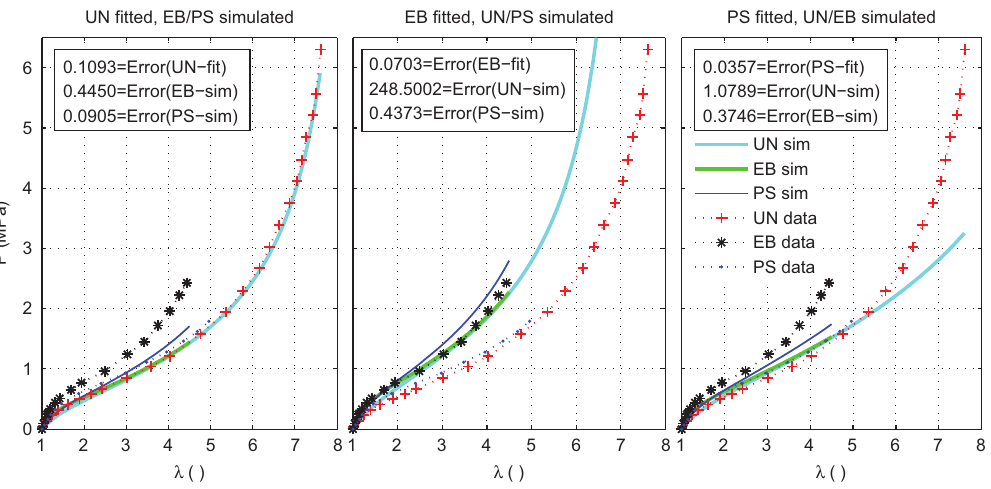
Figure 10 Comparison of the three-chain model with the Treloar